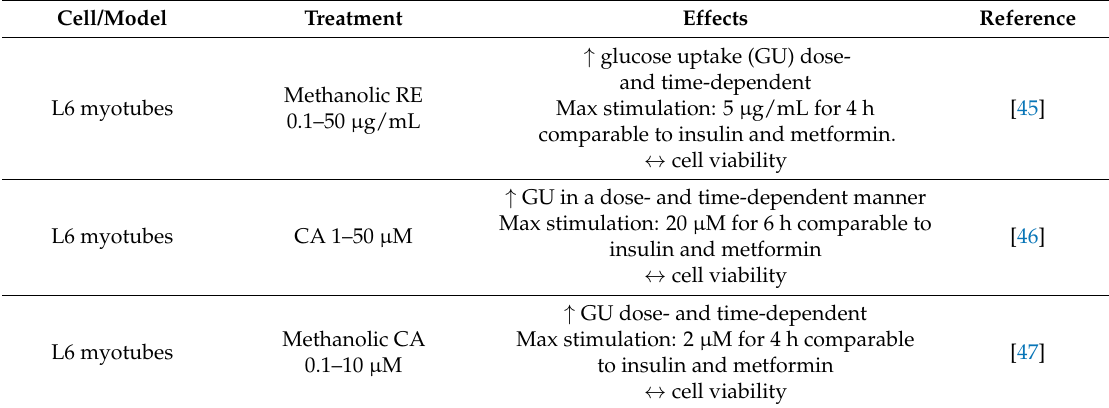
Table 5. Anti-diabetic Effects of Rosemary Extract and its Main Polyphenolic Constituents: in vitro studies (muscle